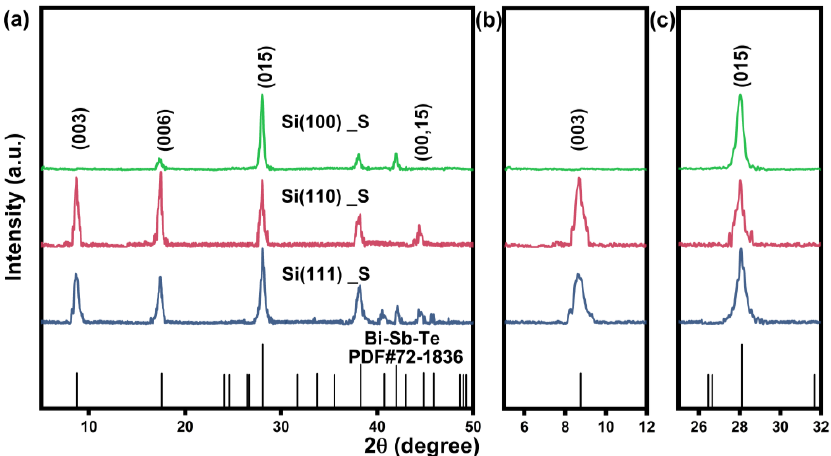
Figure 1. ( a ) XRD patterns of Bi-Sb-Te films deposited on Si substrates with different initial orienta- tions. Magnified XRD patterns of ( b ) (003) and ( c ) (015) peaks.